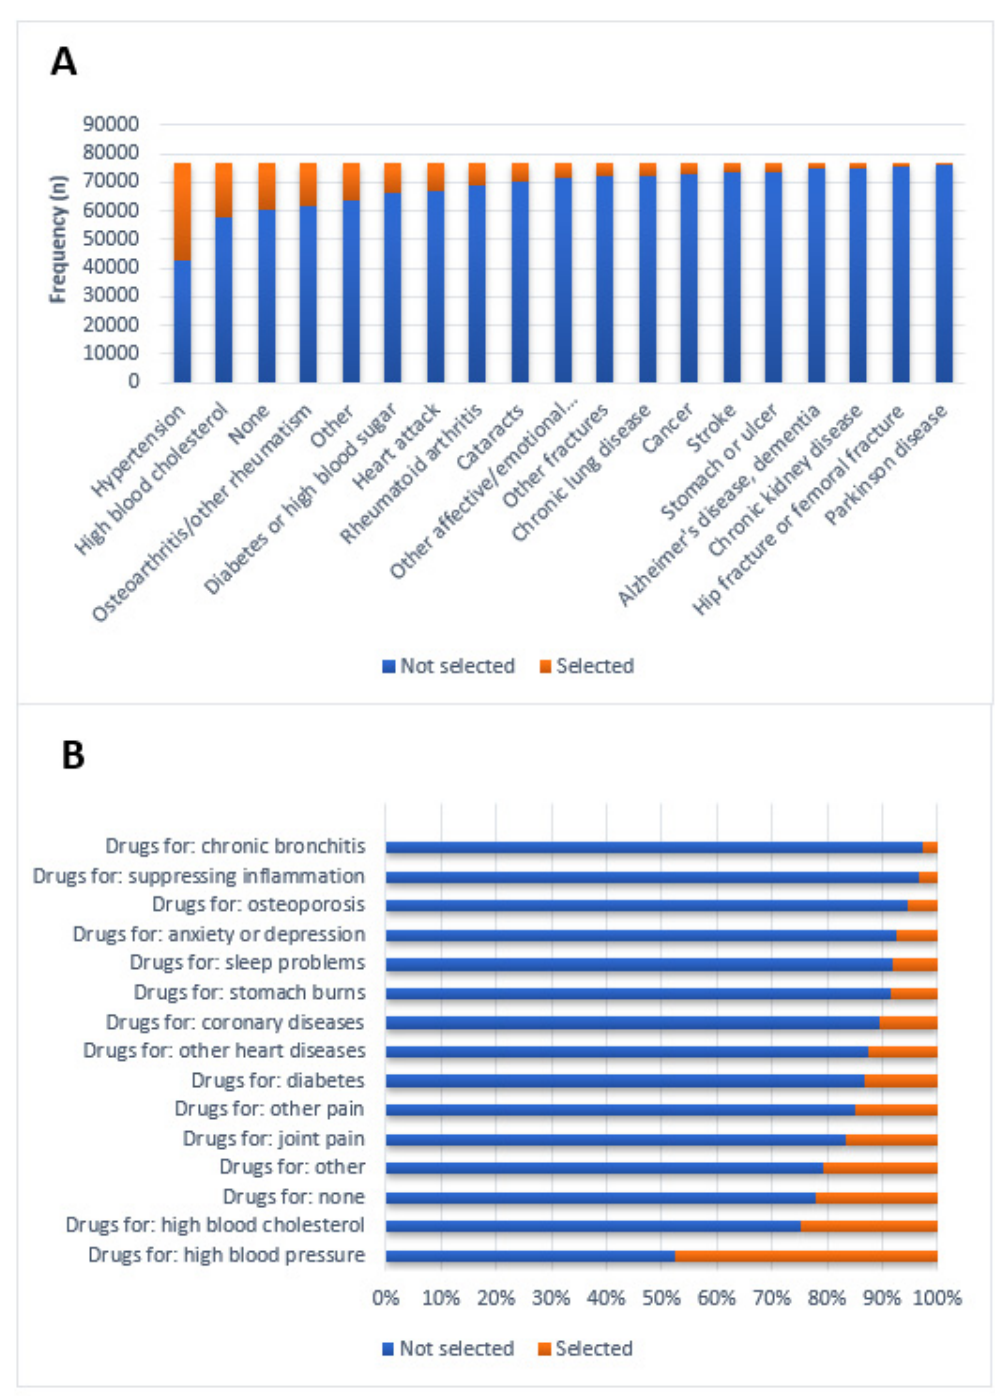
Figure 1. ( A ) Frequencies of self-reported diseases and ( B ) frequencies of self-reported medication use (selected) or nonuse (not selected) in the entire cohort ( n = 76,876).